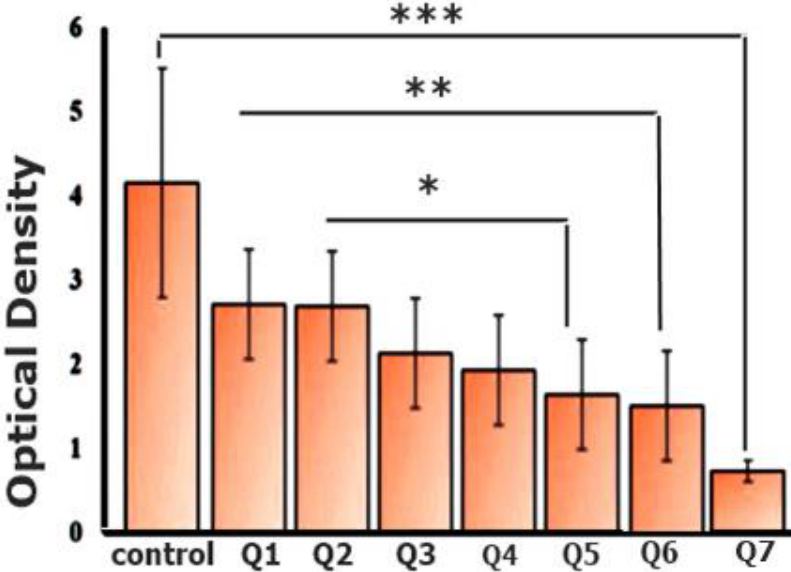
Figure 9. Coagulation analysis of mucoadhesive DXM tablets via optical density determination (Note that * symbol in figure represents p value of 0.0001 to 0.001, while ** means 0.001 to 0.01 and *** corresponds to 0.01 to 0.05)